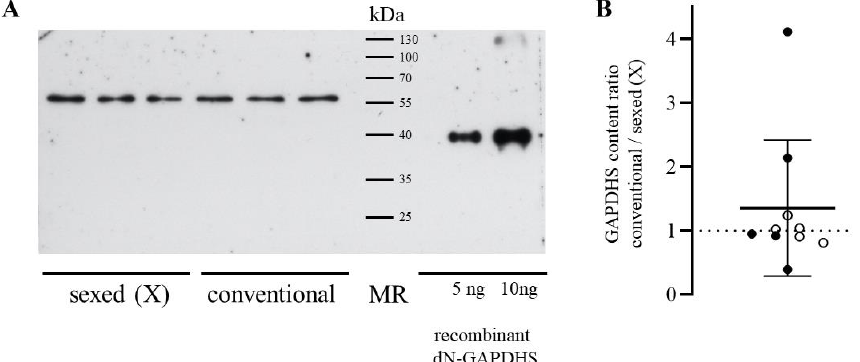
Figure 1. Relative GAPDHS content in the spermatozoa from sexed and conventional bull semen samples ( A ). Western blot of sperm samples derived from two bulls with antibodies against GAPDHS. Recombinant GAPDHS with no N-domain and with known concentrations was used as a control for quantitative analysis. For each sample, 50,000 cells per track were loaded in three repetitions. ( B ). The ratio of GAPDHS content in unsorted semen to GAPDHS content in sexed semen evaluated by densitometry for samples derived from the same bull (white circles) or from different animals (shown with black dots). The bold line corresponds to the mean value and error bars indicate standard deviation.